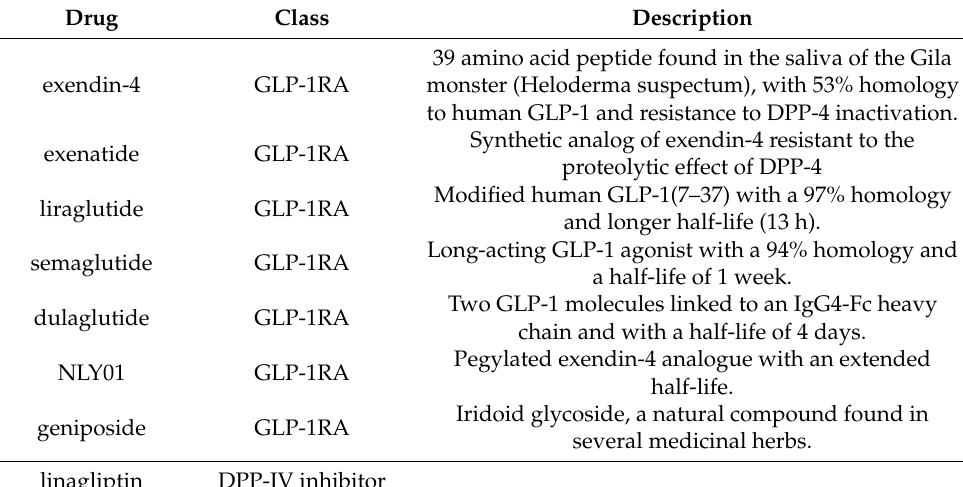
Table 1. Brief description of GLP-1RAs cited in the text. Drug Class Description exendin-4